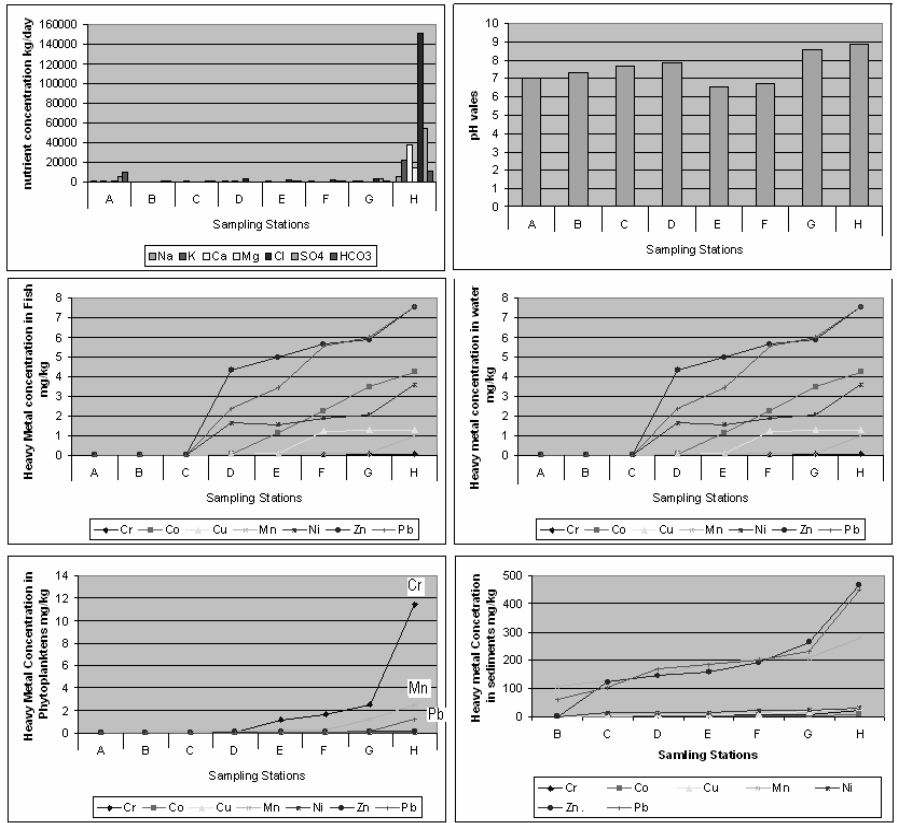
Figure 1 . Chemical profile of Cauvery River water.